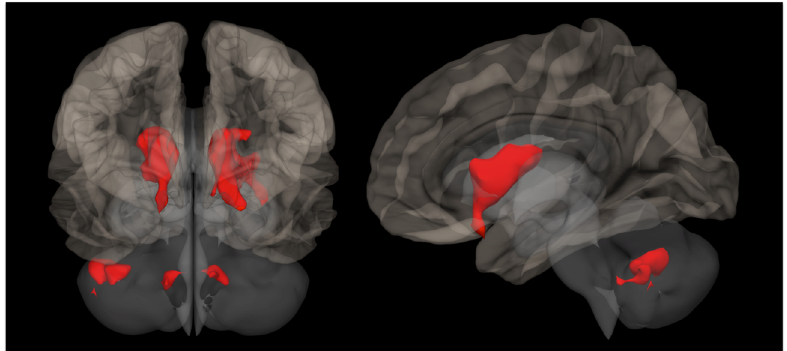
Fig. 5 Three-dimensional rendering of a healthy brain in the Montreal Neurological Institute space showing, in red , regions of reduced functional connectivity with the motor cortex in Fabry disease patients compared to healthy controls (adapted